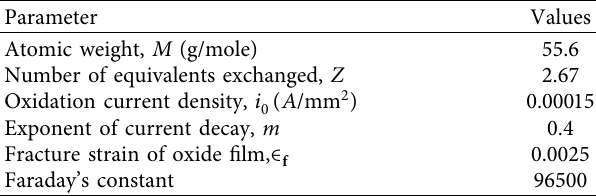
Table 3: Hydrochemical properties of SS-304 [40].